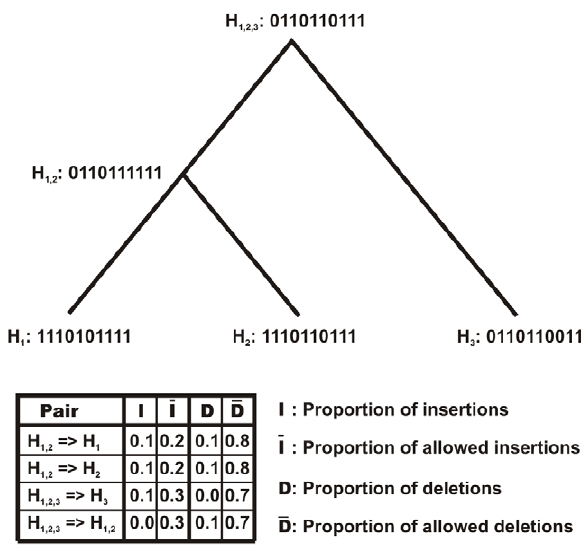
Figure 2. A sample phylogenetic tree for the toy networks shown in Figure 1. The tree contains arbitrary networks assigned at the internal nodes. Also shown are the proportion of insertion and deletion events and the proportion of allowed insertion and deletion events while going from various ancestral networks to descendant